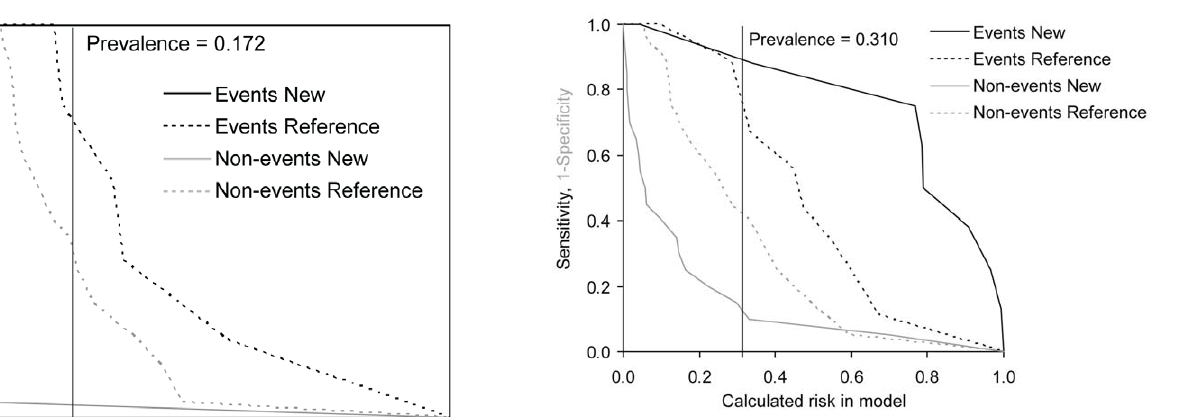
Figure 4. Risk assessment plot of the performance comparison between reference EuroSCORE model and new EuroSCOR- E + MDA model for combined endpoint at 30 days in TAVI group